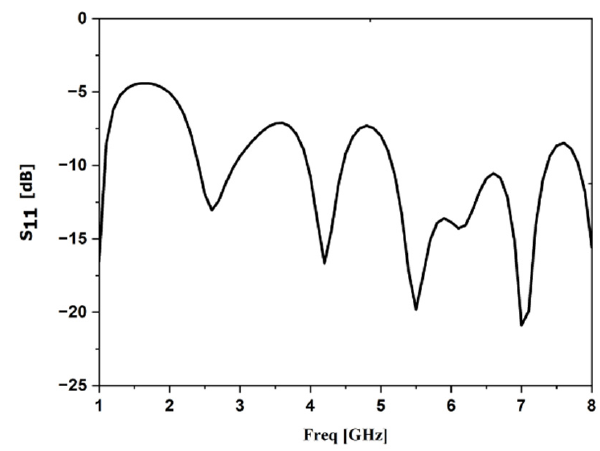
Table 1. Mechanical parameters of the basic Vivaldi antenna (all parameters are presented in mm). The design started with a simulation of a standard antipodal Vivaldi using HFSS software: “commercial 3D solver for electromagnetic structures from Ansys based on the Parameters L finite element method”,. Figure 3 shows the S-parameter simulation results in the free space. Figure 4a shows the gain simulation result versus frequency, and Figure 4b presents the simulated radiation pattern in the proposed frequency for tumor detection (5 GHz), in which it is possible to observe that the proposed antenna is directional with a gain equal to 6 dB.